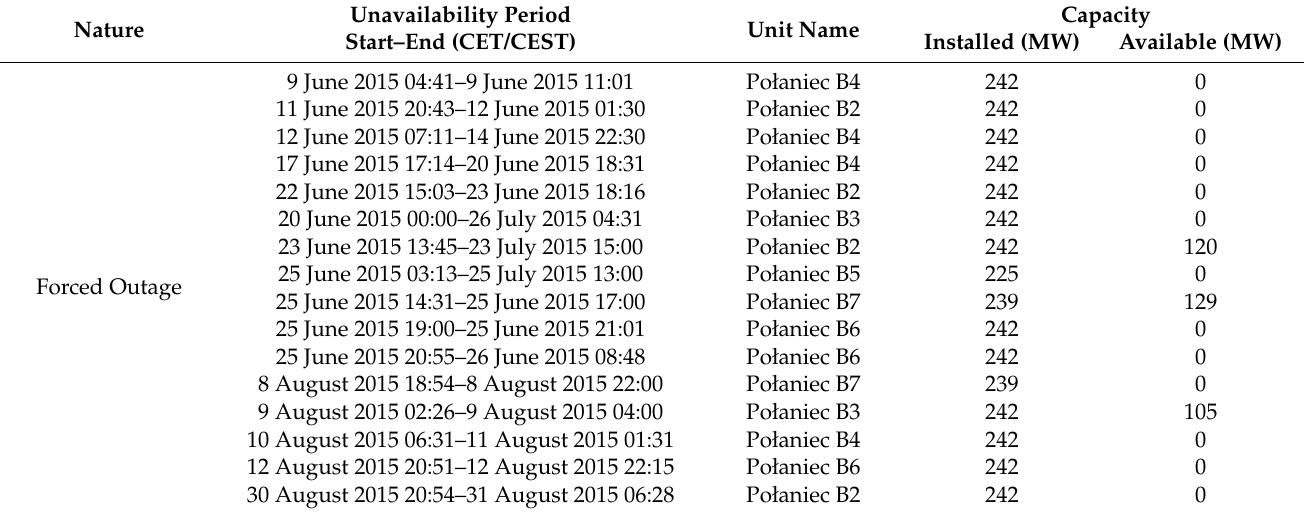
Table 5. Power losses in the Połaniec power plant, June–August 2015 [27].